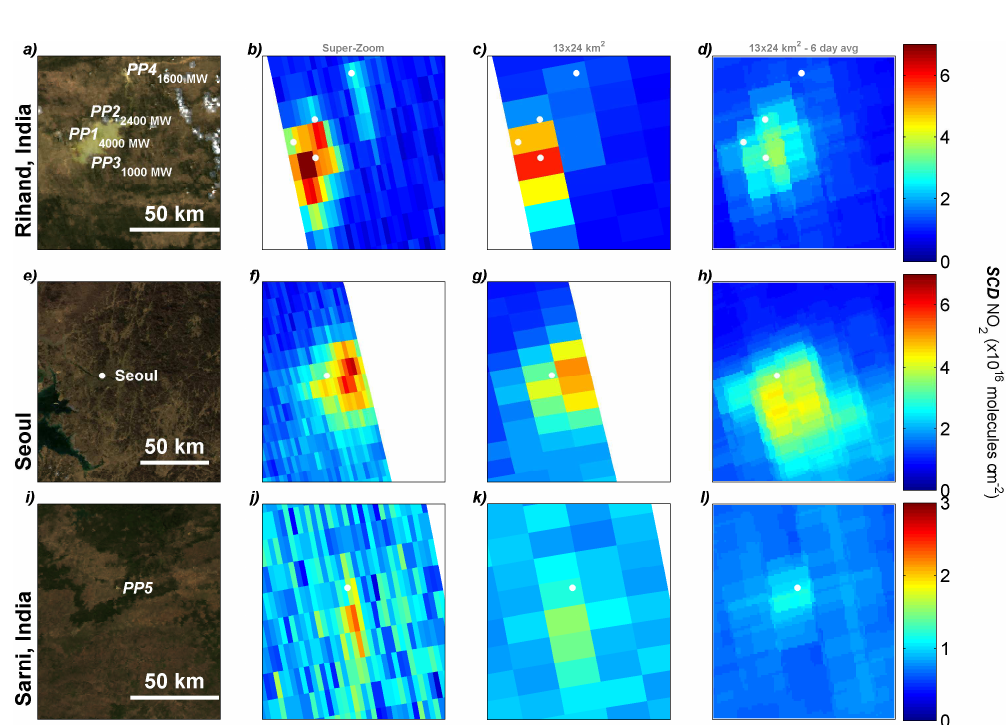
Figure 3. MODIS RGB image, slant column NO 2 retrieved from OMI super-zoom and operational resolution observations, and from six operational resolution observations over the Rihand Reservoir in India (a–d) , Seoul, South Korea (e–h) , and Sarni, India (i–l) . Power plants located around the Rihand Reservoir include Singrauli and Vindhyachal (PP1 – 4200MW), Anpara and Hindalco (PP2 – 2400MW), Rihand (PP3 – 1000MW pre-2006), and Obra (PP4 – 1600MW). Power plants around Sarni, India (i) , include Satpura generating station ( PP5 ).